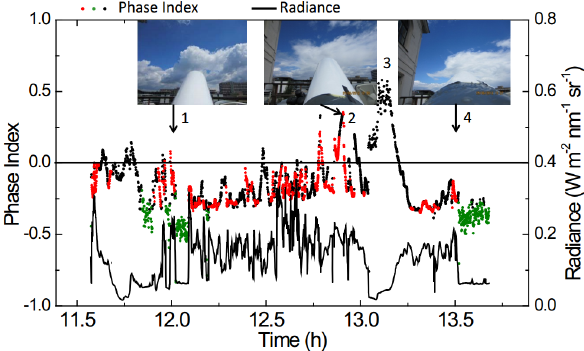
Fig. 8. Time series of spectral radiance at 550nm wavelength (black line) and derived phase index (colored circles). The colors indi- cate the different observing situations: illuminated cloud side (red), cloud shadow/overcast (black), and cloud-free in viewing direction